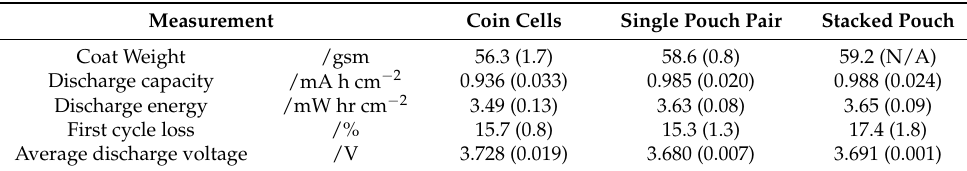
Figure 1. Cell properties with ( a ) cathode coat weights calculated from cell build data and ( b ) areal discharge capacities measured during formation. Table 3. Formation cycle measurements for different cell formats.